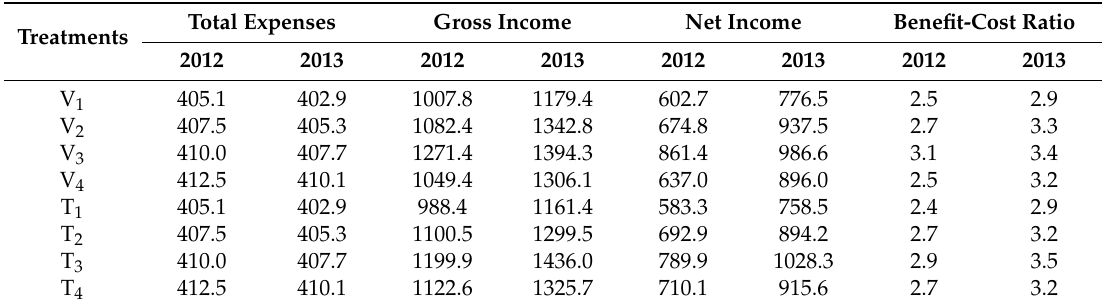
Table 4. Economic analysis (US $ ha − 1 ) for the effect of different sulphur treatments on sesame varieties performance under rainfed